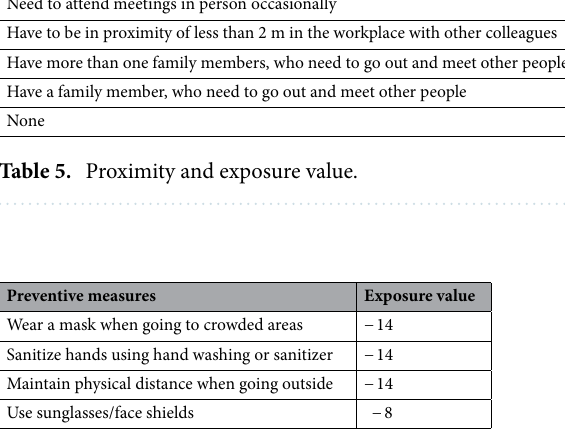
Table 6. Preventive measures and deduction in exposure value.